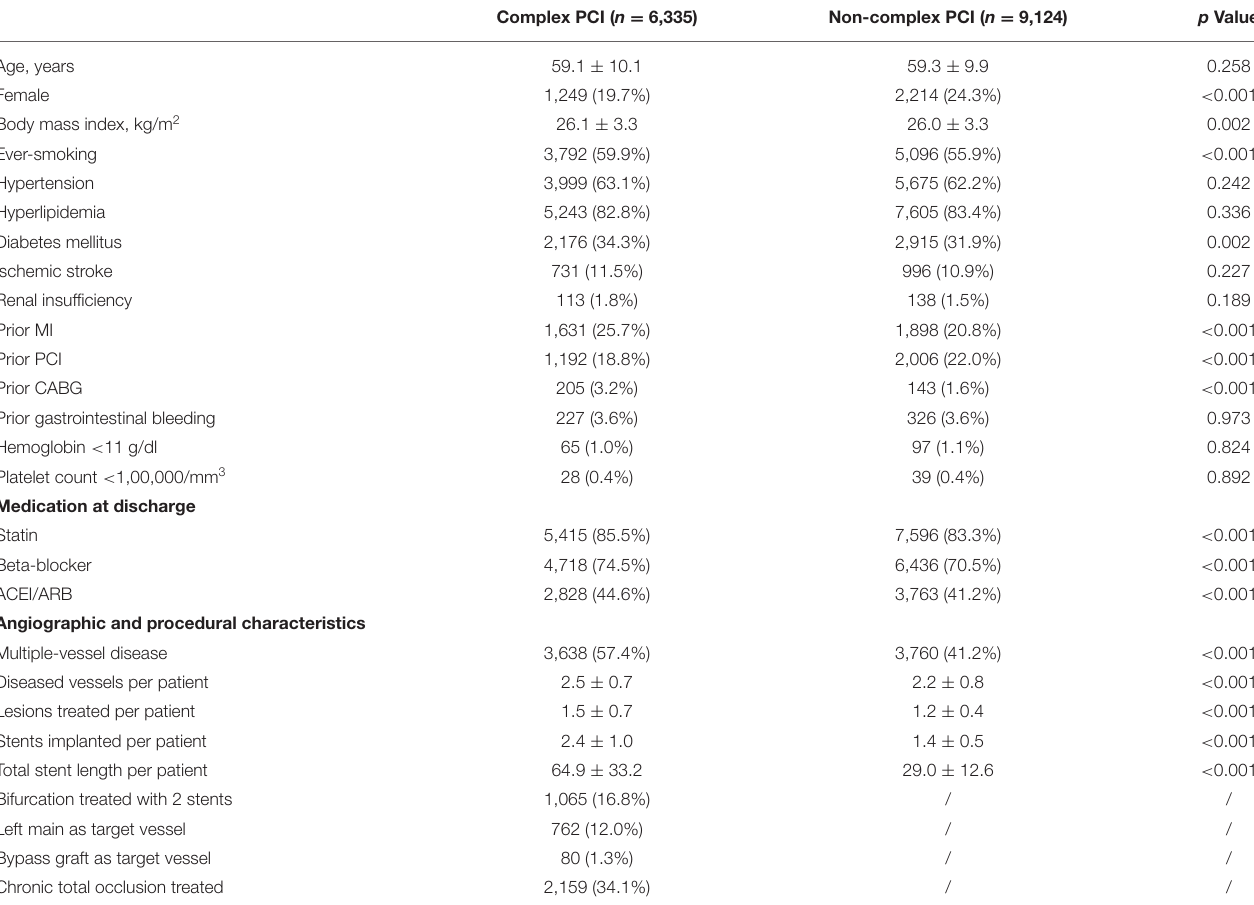
TABLE 1 | Baseline characteristics of patients undergoing complex vs. non-complex PCI.